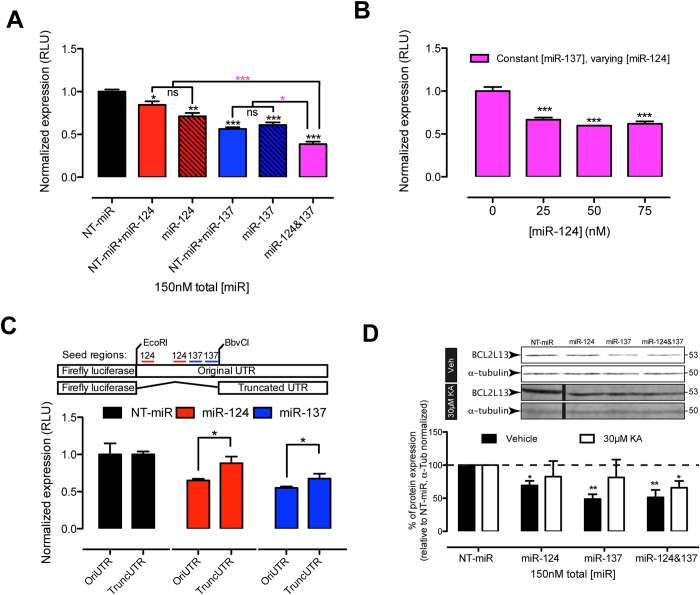
Validation of BCL2L13 as a miR-124 and miR-137 cooperative action.(A) Effect of miR-124 and miR-137 alone or in combination on BCL2L13 3′UTR-driven luciferase expression. Red empty bar: 75 nM miR-124 + 75 nM NT-miR; *p < 0.05; red dashed bar: 150 nM miR-124; **p < 0.01; (blue empty bar: 75 nM miR-137 + 75 nM NT-miR; ***p < 0.001; blue dashed bar: 150 nM miR-137, ***p < 0.001; (purple bar: 75 nM miR-124 + 75 nM miR-137; ***p < 0.001. All conditions compared to 150 nM NT-miR (black bar). The equimolar combination of miR-124 and 137 (purple bar) induced significantly larger downregulation of luciferase, compared to all other conditions (red empty bar: ***p < 0.001; red dashed bar, ***p < 0.001; blue empty bar, *p < 0.05; blue dashed bar, *p < 0.05). Values represent mean normalized expression (RLU) ± SEM of three independent experiments. (B) Effects of increasing concentrations of miR-124 in the presence of 75 nM miR-137. Values represent mean normalized expression to 75 nM miR137 + 75 nM NT-miR (0 nM miR-124) ± SEM of three independent experiments (***p < 0.001 compared to 0 nM miR-124). (C) Scheme of original and truncated pEZX-MT01-mouse-3 kb-BCL2L13-3′UTR and bar graph showing a significant reduction of luciferase expression (OriUTR + NTmiR vs. + miR-124 or + miR-137, *p < 0.05) and a significant rescue (Ori. vs. Trunc. UTR with same miR, *p < 0.05) of miR-mediated luciferase expression in the absence of miR-124 and 137 binding regions. Values represent mean normalized expression (RLU) ± SEM of three independent experiments. In all cases, total miR concentration was kept constant at 150 nM by adding non-targeting miR (NT-miR). (D) Representative immunoblots and bar graph displaying miR induced changes in endogenous BCL2L13 expression in hippocampal NSPC. Black bars: vehicle-treated NSPC cultures, 150 nM miR-124 (miR-124, *p < 0.05), 150 nM miR-137 (miR-137 **p < 0.01) and 75 nM miR-124 + 75 nM miR-137 (miR-124&137, **p < 0.01) significantly reduced BCL2L13 protein expression. White bars: KA-treated NSPC cultures, only 75 nM miR-124 + 75 nM miR-137 significantly reduced BCL2L13 protein expression (miR-124&137, *p < 0.05). All miR treatments compare to 150 nM NT-miR. Values represent mean ± SEM of three independent experiments performed in triplicates. Bands belong to the same blot, but were re-ordered for clarity of the figure. Cropping lines are indicated by vertical black lines and full-length blots are presented in Supplementary Fig. 7. In all cases total miR concentration was kept constant at 150 nM by adding NT-miR.